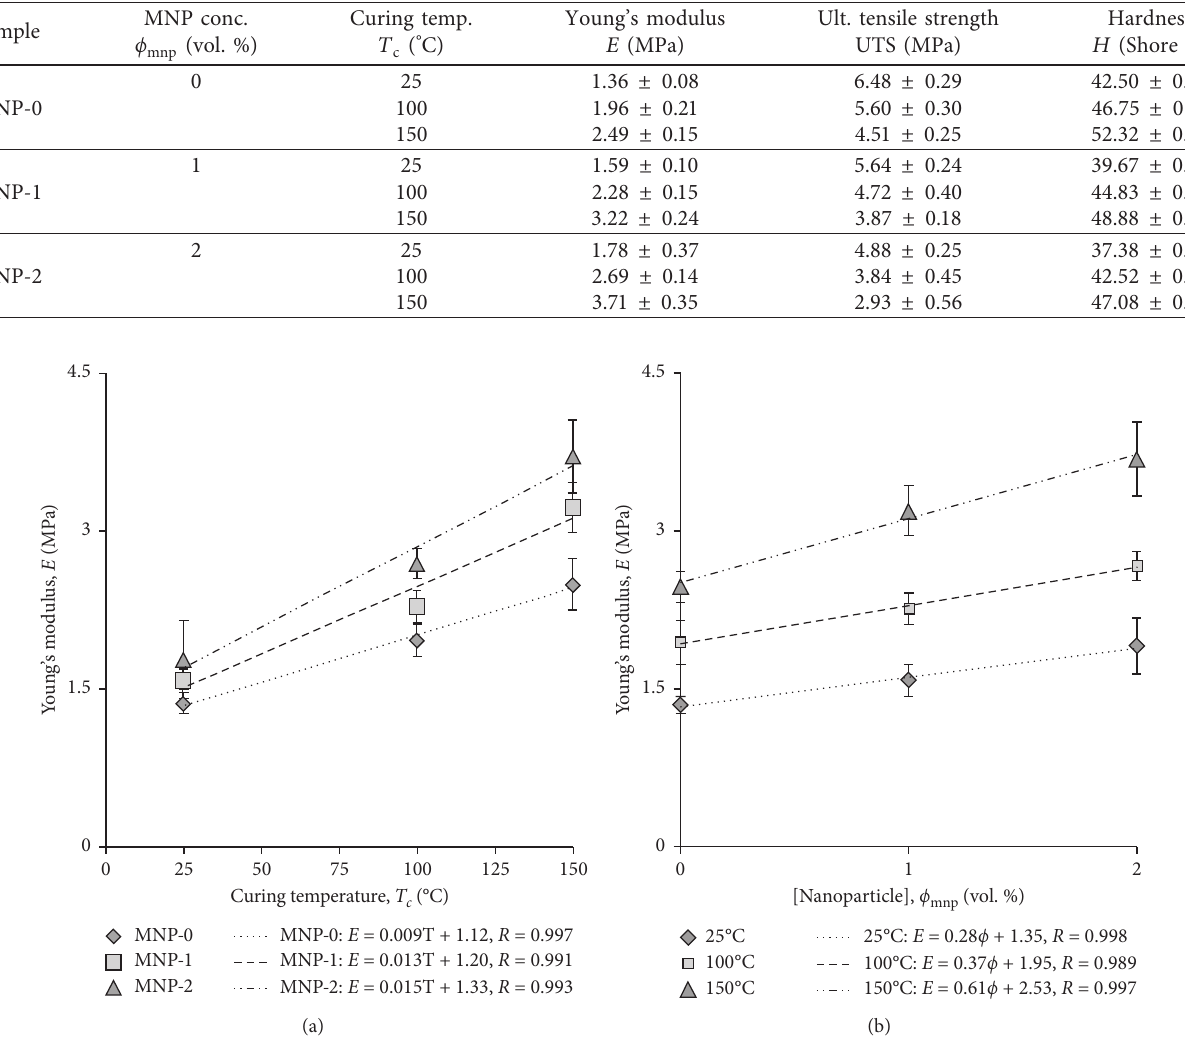
Figure 2: Young’s modulus, E , as a function of (a) curing temperature, T different T c